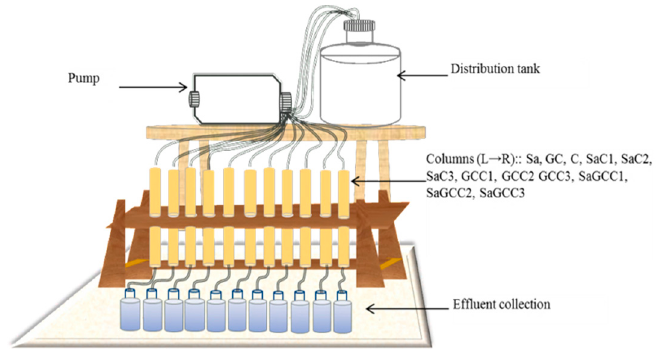
Figure 1. Packed bed reactor design and operation (Sa, sand; GC, gas concrete; C, biochar; SaC, sand + biochar; GCC, gas concrete + biochar; SaGCC, sand + gas concrete + biochar).